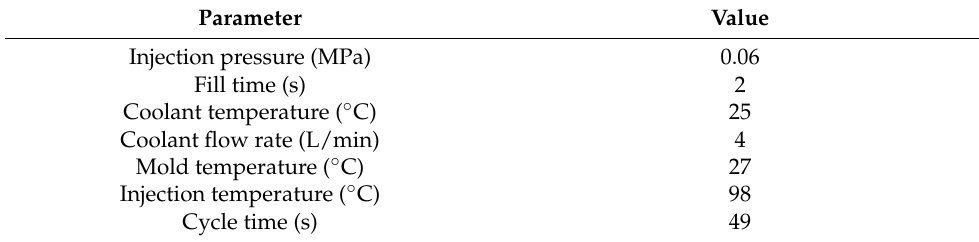
Figure 4. Experimental setup for evaluating the effectiveness of the injection mold before and after heat treatment. Table 3. Boundary conditions used in low-pressure wax injection